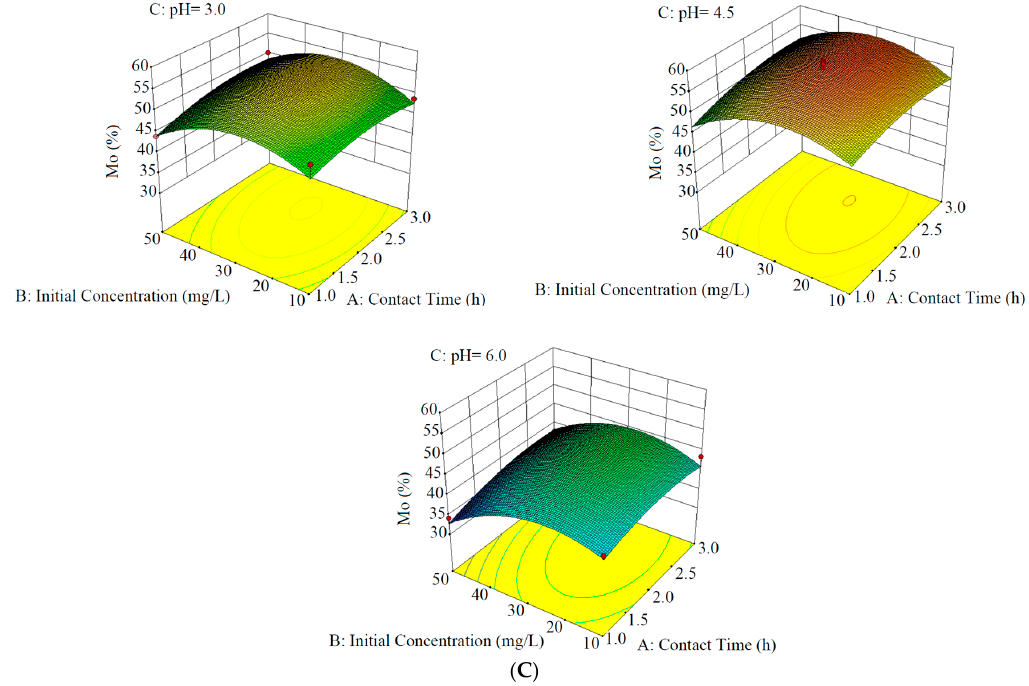
Figure 3. Three-dimensional surface plots of ( A ) ammonia, ( B ) phenol, and ( C ) Mo removal.